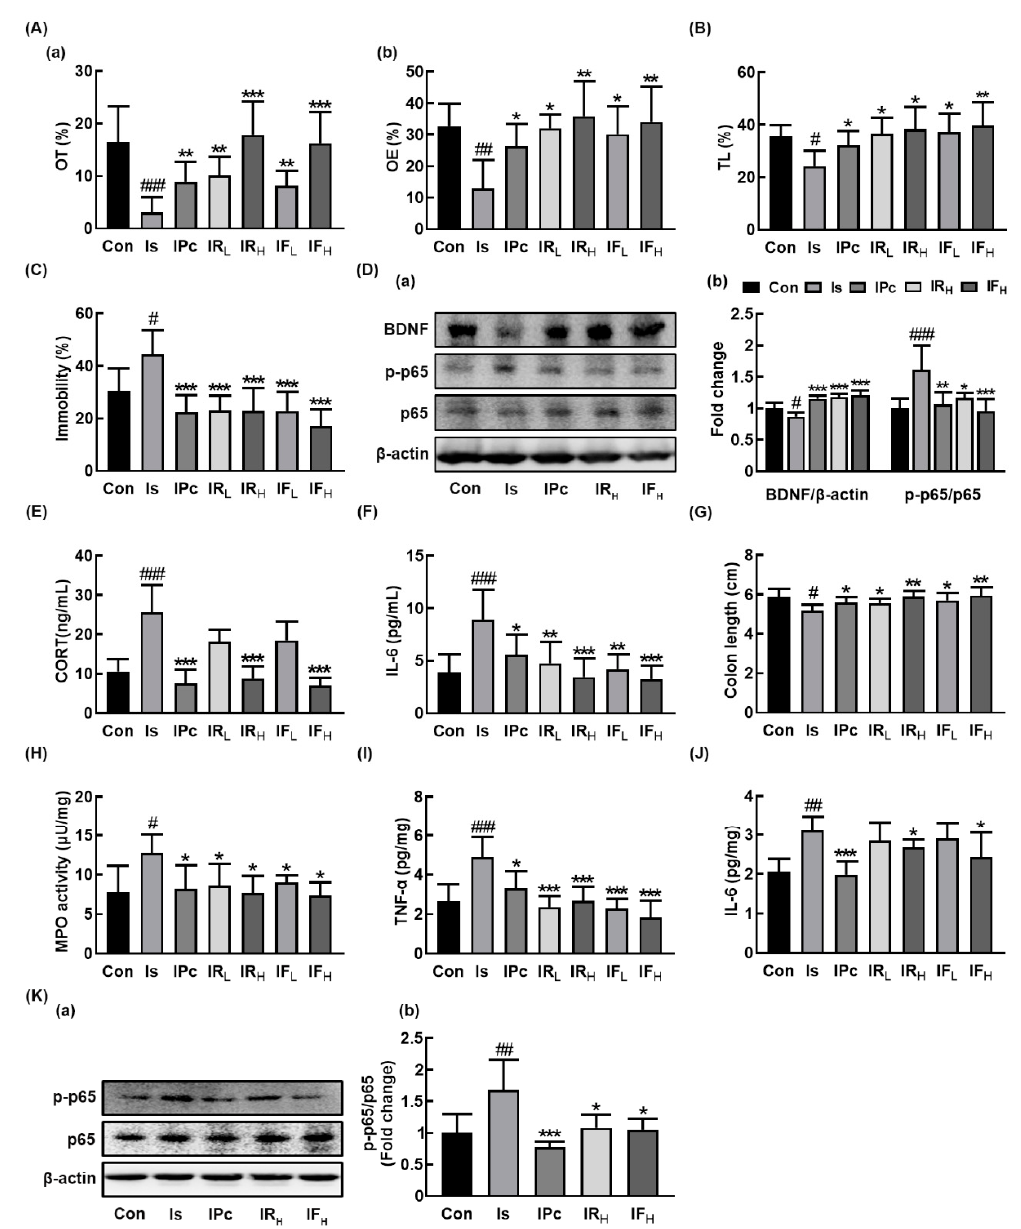
Figure 1. Oral administration of RG or fRG alleviated immobilization stress (IS)-induced anxiety / depression and colitis in mice. Effects on anxiety / depression-like behaviors in elevated plus maze ( A : ( a ), open arms (OT); ( b ), open arm enteries (OE), light / dark transition test ( B ), and forced swimming test ( C ). ( D ) Effects on brain-derived neurotrophic factor (BDNF) expression, NF- κ B activation ( a ), and their intensities of BDNF/ β -actin and p-p65/p65 ( b ) in the hippocampus. Effects on corticosterone (CORT, E ) and IL-6 levels ( F ) in the blood. Effects on colon length ( G ), myeloperoxidase (MPO) activity ( H ), TNF- α ( I ) and IL-6 ( J ) expression, and NF- κ B activation ( K ( a )) and its intensity (K( b )) in the colon. Mice were exposed to immobilization stress (IS) and test agents (Is, vehicle [saline]; IPc, 10 mg / kg / day of fluoxetine; IRL, 10 mg / kg / day of RG; IRH, 25 mg / kg / day of RG; IFL, 10 mg / kg / day of fRG; IFH, 25 mg / kg / day of fRG) were gavaged daily for five days. Normal control group (Con) not exposed to IS was treated with saline instead of test agents. Hippocampal p65, p-p65, BDNF, and β -actin were analyzed by immunoblotting. Blood IL-6 and corticosterone levels were assayed by ELISA kits. Data values were indicated as mean ± SD ( n = 6). # p < 0.05 vs. Con group. ## p < 0.01 vs. Con group. ### p < 0.001 vs. Con group. * p < 0.05 vs. Is group. ** p < 0.01 vs. Is group. *** p < 0.001 vs. Is